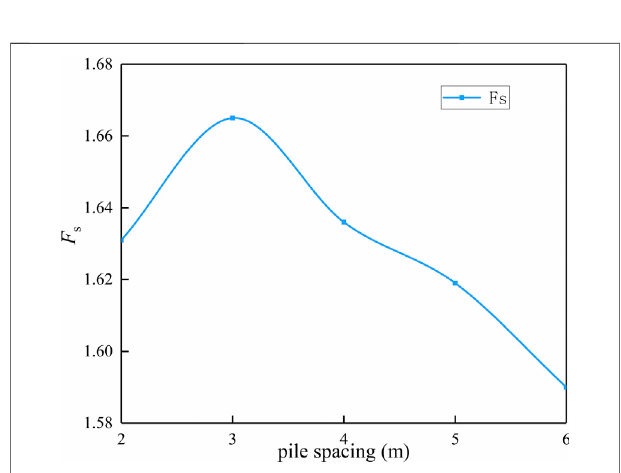
FIGURE 13 | Slope safety factors with different pile